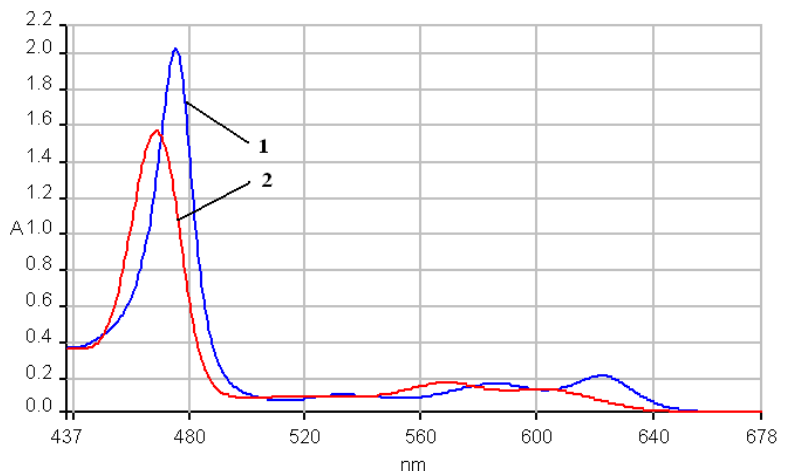
Figure 9. The overlapped UV-vis spectra of 2a (line 1), and of the hybrid silica material 2a-A (line 2-pH = 1.5), in THF.